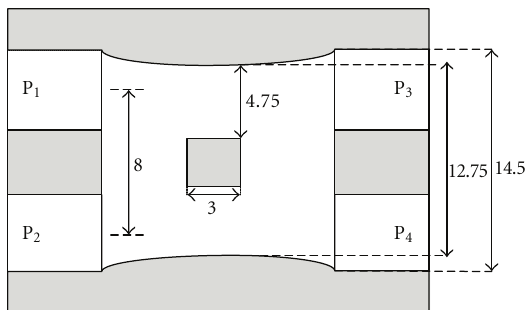
Figure 2: Circuit of the nonuniform branch line coupler.